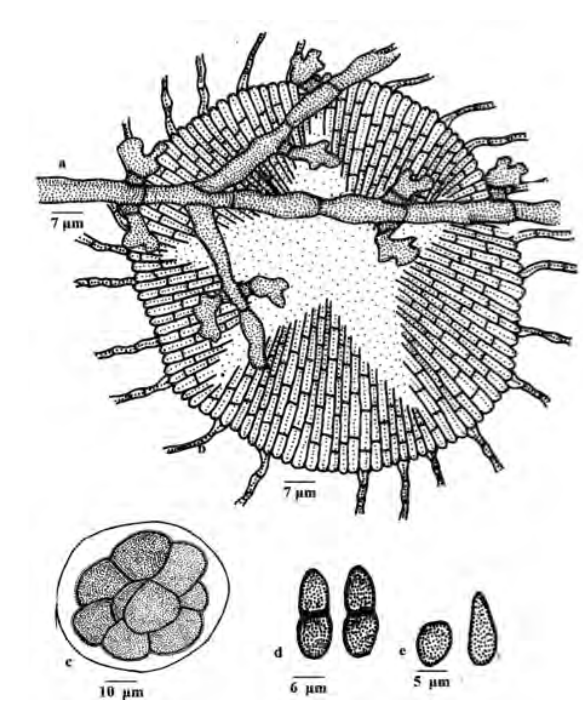
Figure 153. Asterina lobulifera var. indica a - Appressorium; b - Thyriothecium; c - Ascus; d -